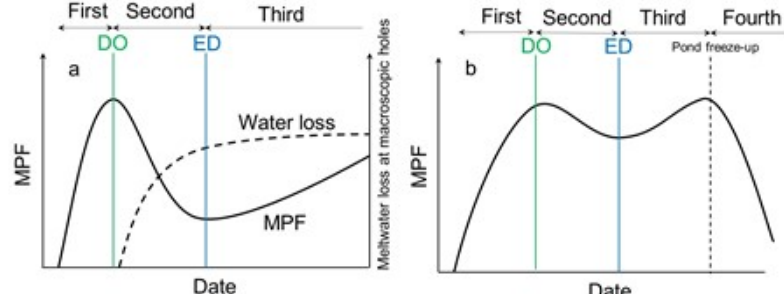
Figure 1. Conceptual sketch of the temporal evolution of melt pond fraction (MPF) (solid curve) and meltwater loss at macroscopic holes (dashed curve) in. ( a ) Drainage onset (DO) is determined as the first maximum. End of drainage (ED) is determined as the first minimum in ( b ).